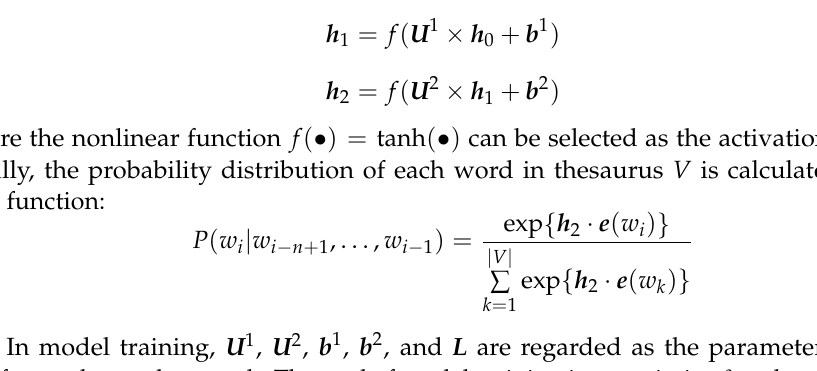
Figure 2. Feedforward neural network language model. h 0